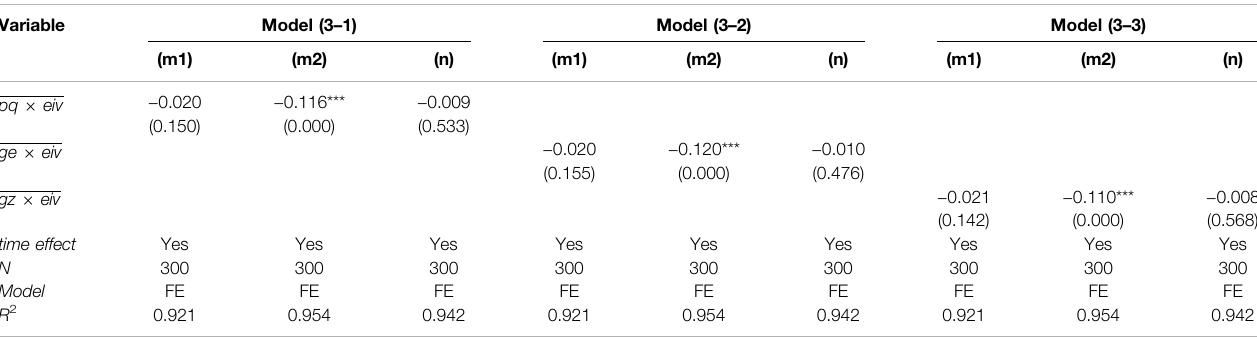
TABLE 11 | Extension results of Model